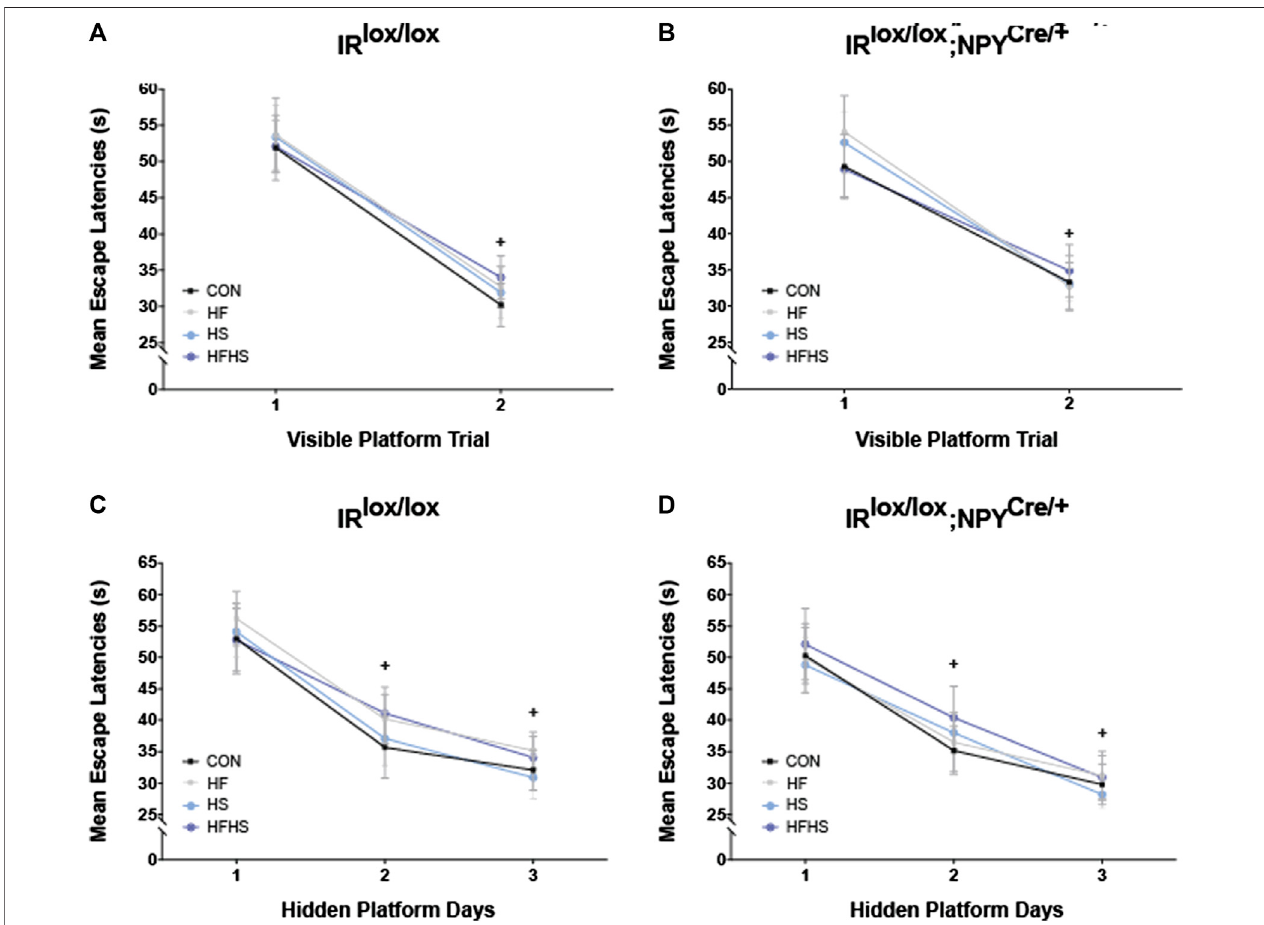
FIGURE 3 | Morris Water Maze performance – Mean Escape Latencies. Mean escape latencies were collected for each trial day to assess performance over time. Across all dietary treatment groups, mean escape latencies were signi fi cantly decreased on Day 2 of visible platform trial for IR lox/lox control mice and IR lox/lox ;NPY Cre/+ mice (A, B) . IR lox/lox mice and IR lox/lox ;NPY Cre/+ mice reached the platform faster across the hidden platform days in all treatment groups (C, D) . CON = chow diet, HF = highfatdiet,HS=highsugardiet,HFHS=highfatandhighsugardiet.Valuesareexpressedasmean±SEM.+=maineffectoftime, p < 0.05.Analysedbyamixed ANOVA followed by Tukey ’ s honest signi fi cance difference (HSD) test. IR lox/lox ; n = 48 (12/diet group). IR lox/lox ;NPY Cre/+ ; n = 48 (12/diet